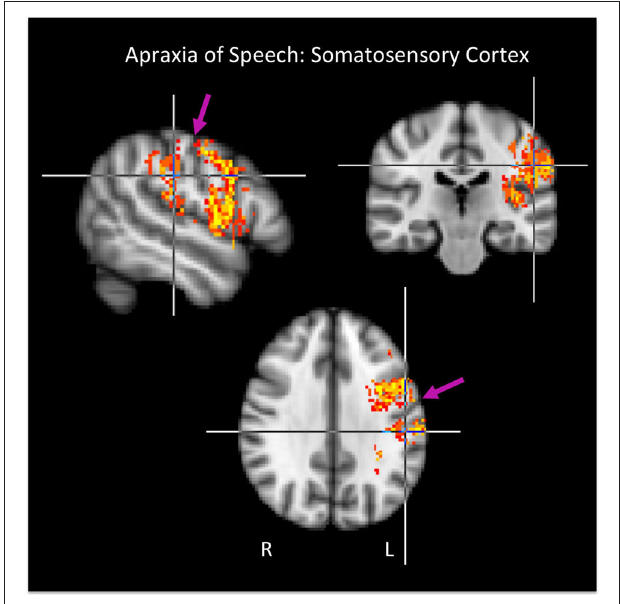
FIGURE 3 | Group maps showing voxels in somatosensory cortex significantly related to apraxia of speech . Arrows indicate the central sulcus.